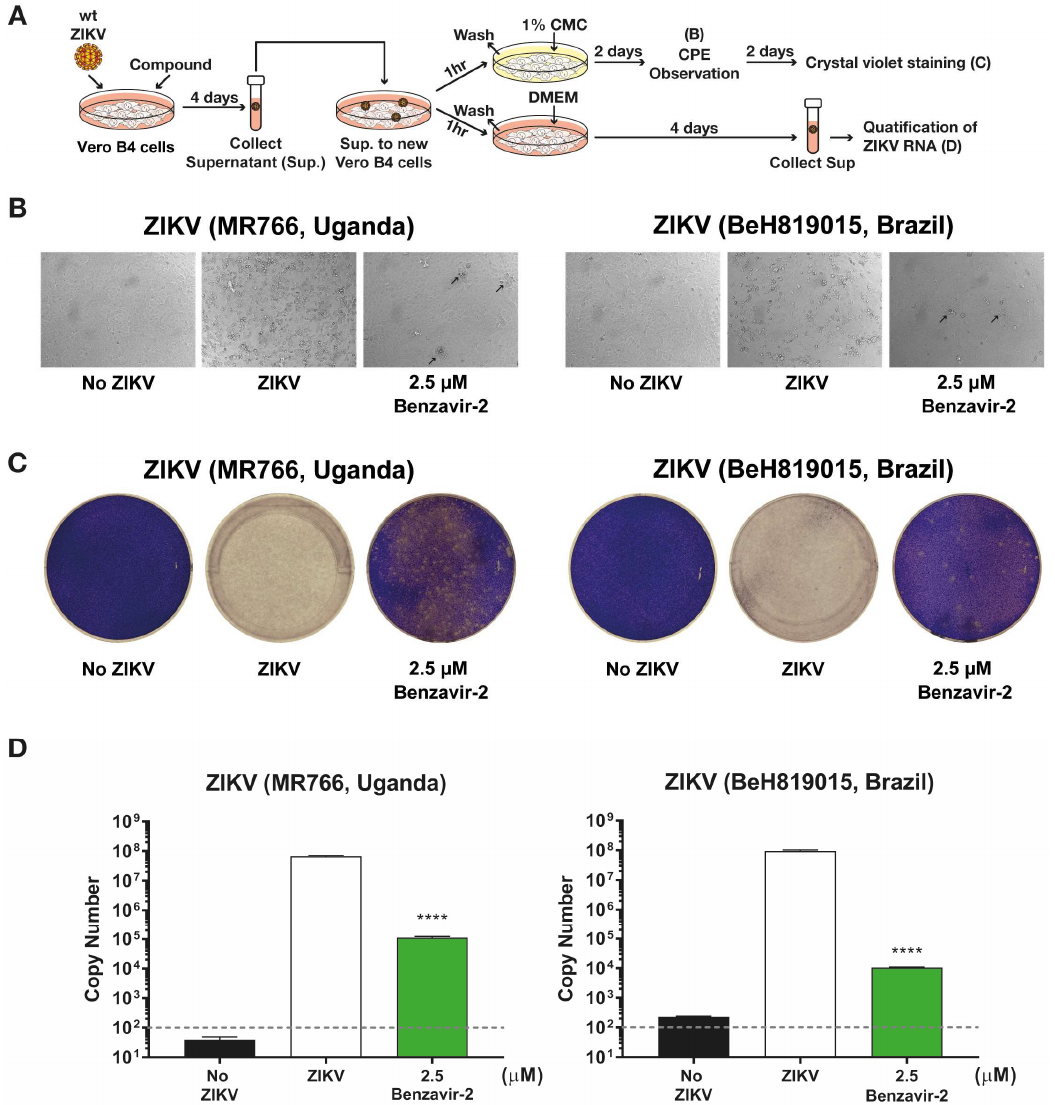
Figure 4. Inhibition of infectious progeny virus production by benzavir-2. ( A ) Schematic diagram for analysis of progeny virus production. Vero B4 cells were seeded in 12-well plates (2 × 10 5 cells per well) and the virus (300 PFUs), together with 2.5 µM of benzavir-2. Cells were incubated for 4 days. The supernatants were collected from two different ZIKV lineage infected cells with or without compounds. Next, the collected supernatants were transferred to a new Vero B4 cell layer for 1 h and replaced with DMEM with 1% CMC (for cytopathic effect (CPE) observation and crystal violet staining) or with DMEM (for qRT-PCR), respectively. ( B ) Microscopy images of the virus-infected cells on day 2. Black arrows indicate CPE onset. ( C ) Plaque formation determined by crystal violet staining on day 4. Representative images are shown in B and C. ( D ) Quantification ZIKV RNA from collected supernatant on day 4 post-infection. The grey-dashed line represents the detection limit of qRT-PCR. Mean values and standard deviations are shown from three independent experiments. The statistical significance was determined by one-way ANOVA, followed by Dunnett’s multiple- comparisons test. **** p < 0.0001.